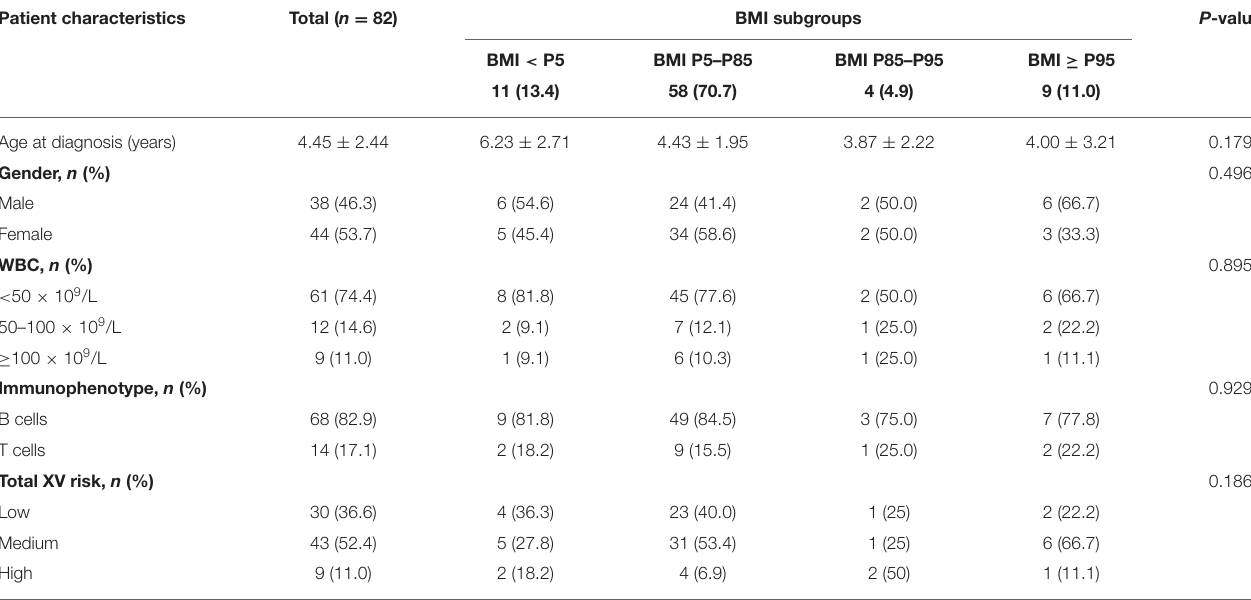
TABLE 2 | Patient characteristics based on body mass index.